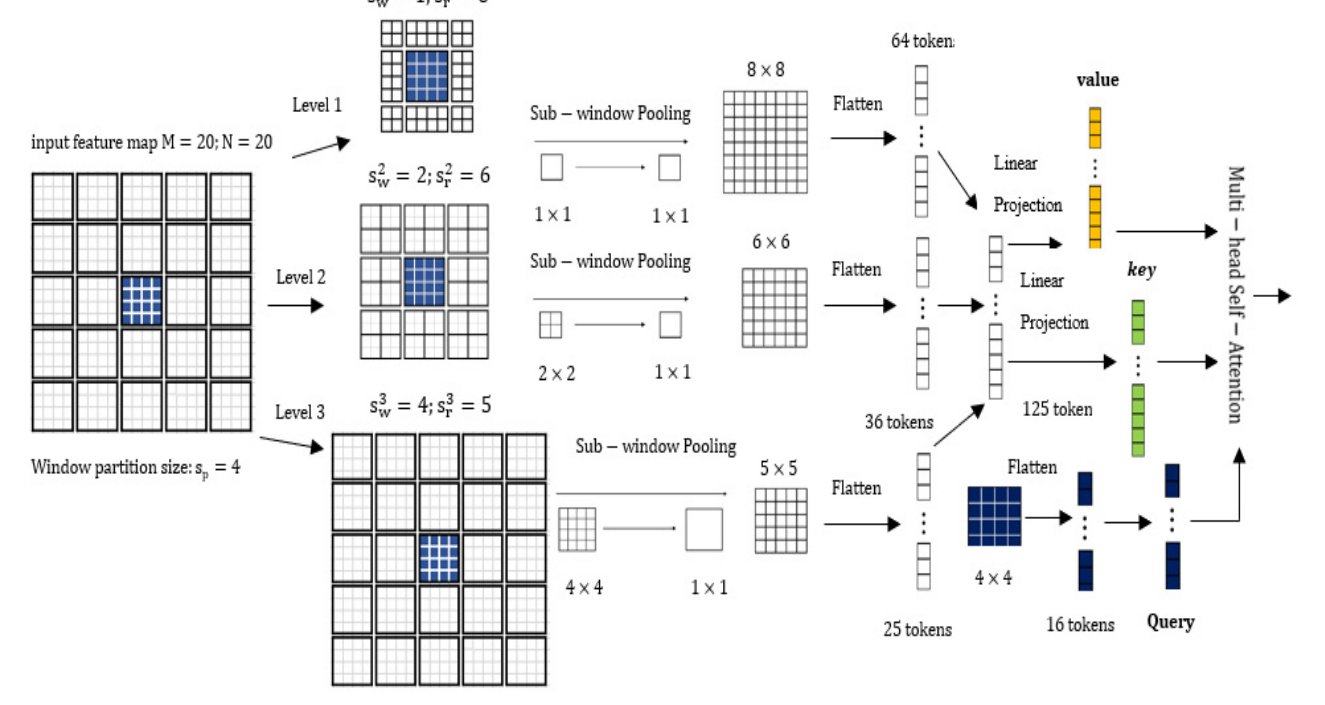
Figure 5. The focus self-attention mechanism in the window level.